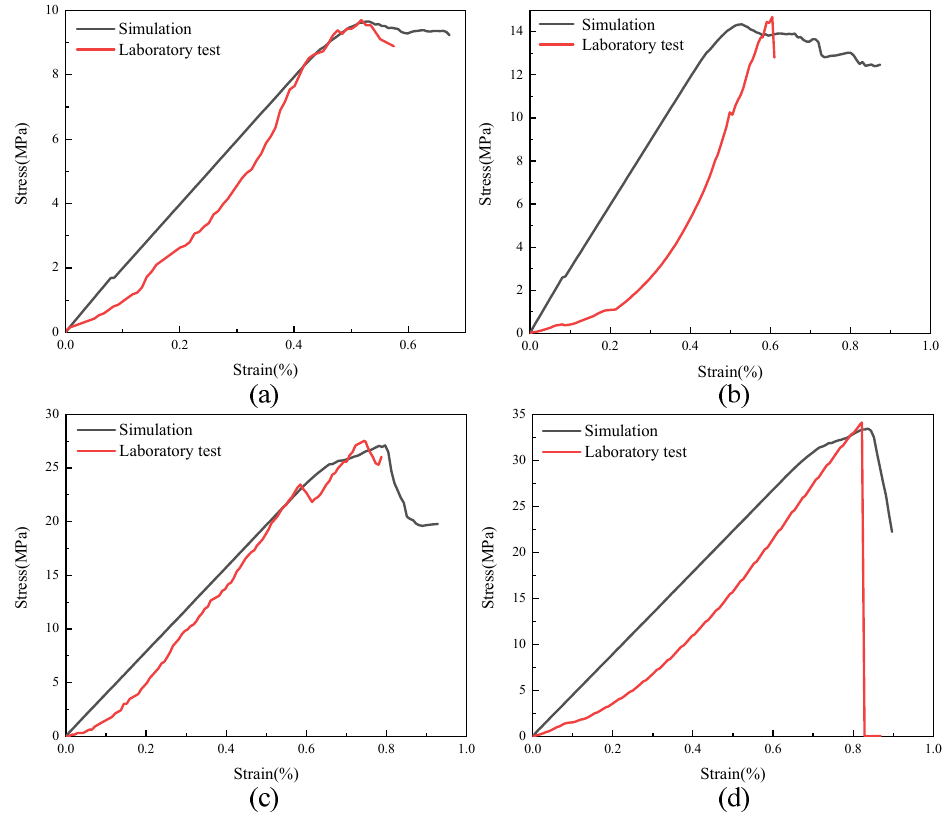
are more accurate in capturing the fracturing damage at the upper left and lower right corners of the sample, and they well describe the three stages of the rheology of sandy mudstone. The simulation results of accelerated rheology time and final deformation are basically consistent with the test results.